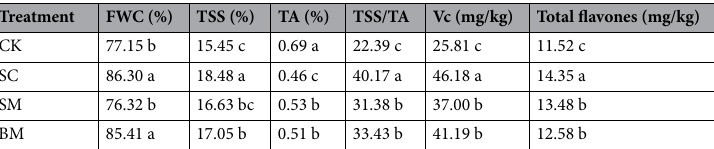
Table 6. Effects of different fertilizer treatments on nutrient quality of Pear-jujube. At different levels, each population mean follows a normal distribution with the same variance. The least significant difference (LSD) method was selected for analysis of variance in DPS software. Different lowercase letters in the same column indicate significant difference between treatments ( P < 0.05). FWC Fruit water content, TSS Total soluble solid, TA Titratable